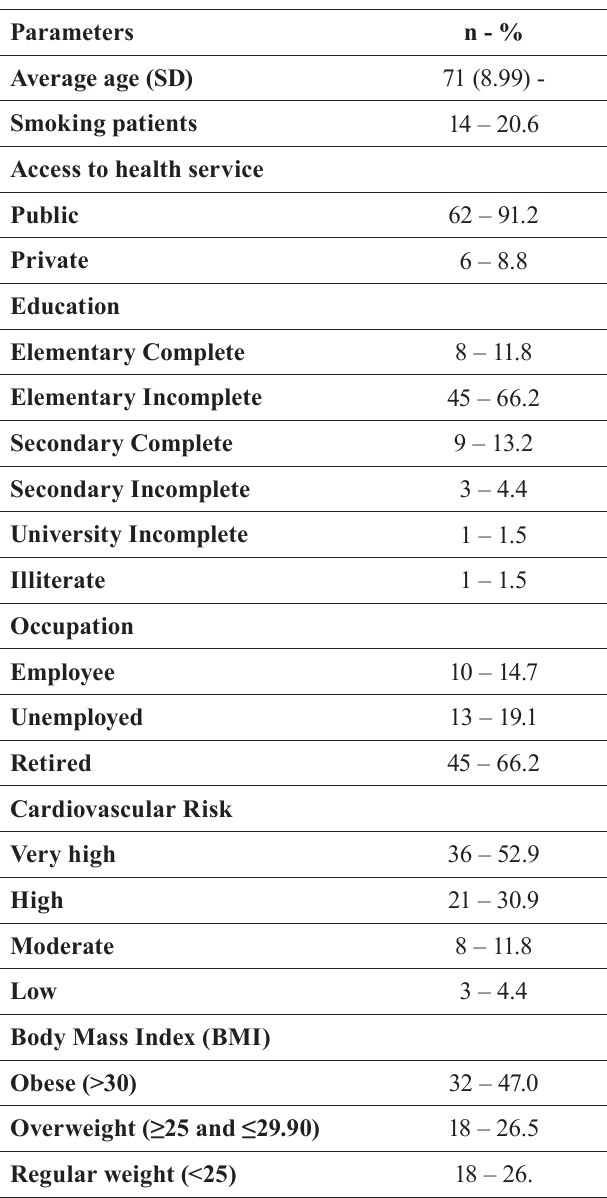
TABLE I - S ociodemographic and clinic data collected at the baseline of the pharmacotherapeutic follow-up, of the studied